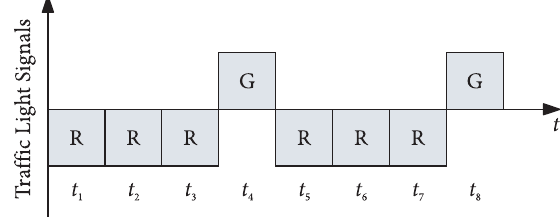
Fig. 5. Th e time diagram of forming traffi c lights